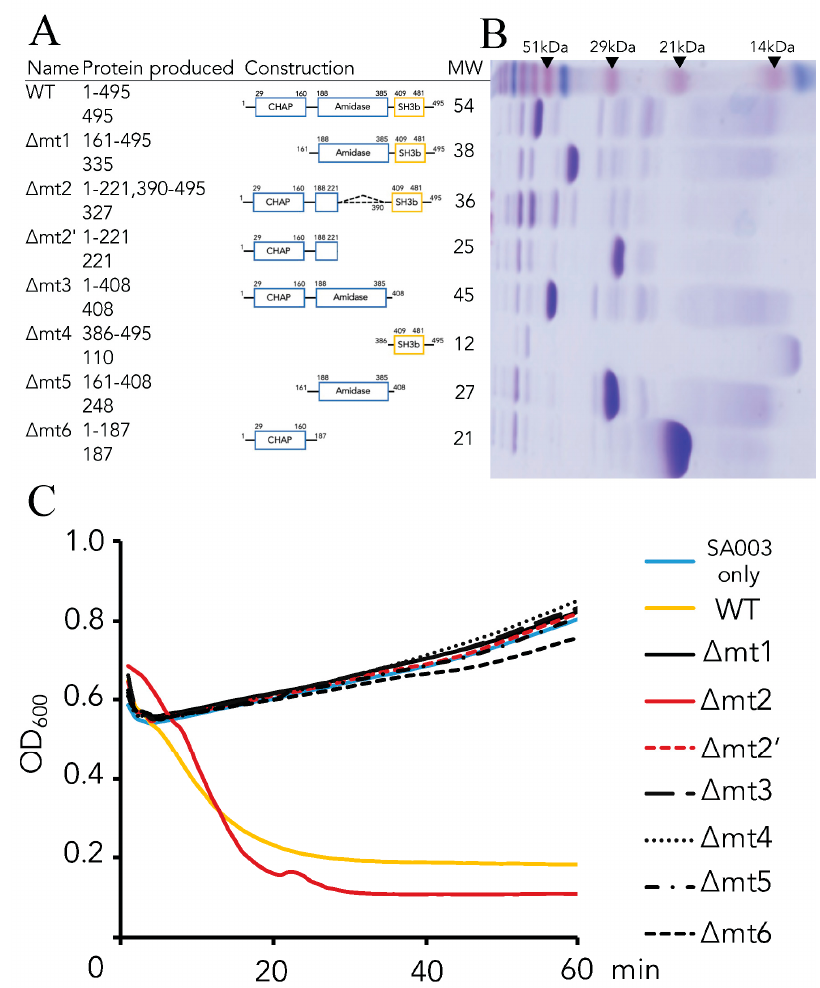
Figure 3. Schematic representation of Lys-phiSA012 and domain(s) deletion mutants and their lytic activities towards SA003. ( A ) Schematic representation of the Lys-phiSA012 protein construct. Amino acid residues 29–160: CHAP domain, 188–385: AMID domain, 409–481: SH3b domain. ( B ) SDS-PAGE of purified Lys-phiSA012 and each domain(s) deletion mutant, performed using 15% polyacrylamide gel. Upper lane; Standard molecular weight markers. ( C ) Lytic activities of Lys-phiSA012 and each domain(s) deletion mutant towards SA003. Except for ∆ mt2, 163.8 pmol of the endolysin was added to the culture medium. For ∆ mt2, 45.98 pmol was